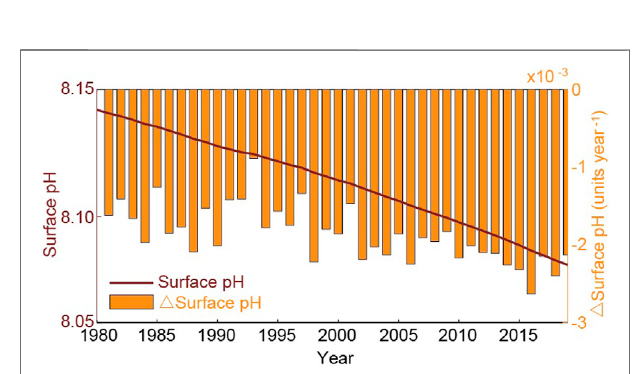
FIGURE5 | Model-simulated time series of annual mean sea surface pH in Zhejiang offshore (line). Changes of surface pH relative to the previous year are also shown by the